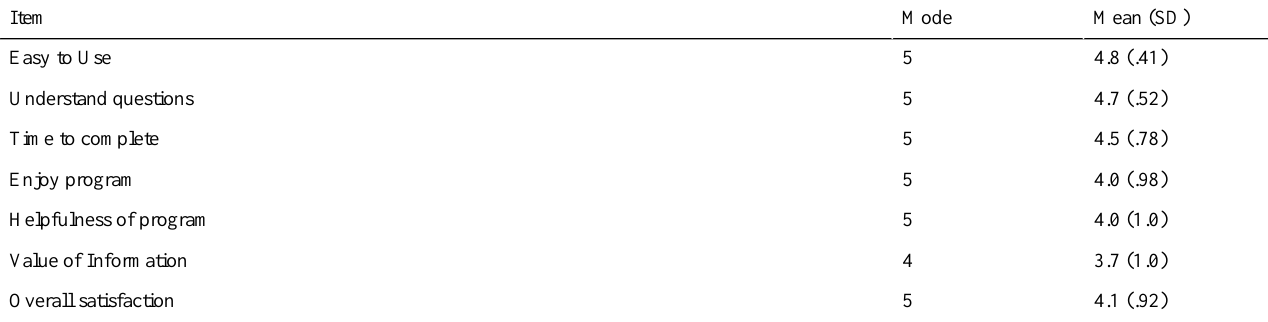
Table 5. Overall P3P Acceptability